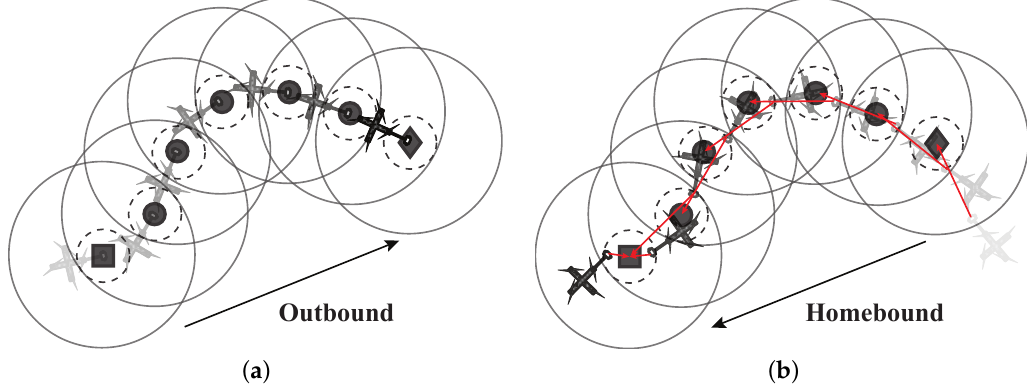
Figure 11. Illustration of a quadrotor performing route learning ( a ) and route following ( b ) using snapshots only. The solid grey circles represent the catchment areas and the dashed circles are the snapshot vicinities. The filled circles depict the locations of the various snapshots, and the home and goal locations are denoted by the square and diamond respectively. The red arrows represent the local homing